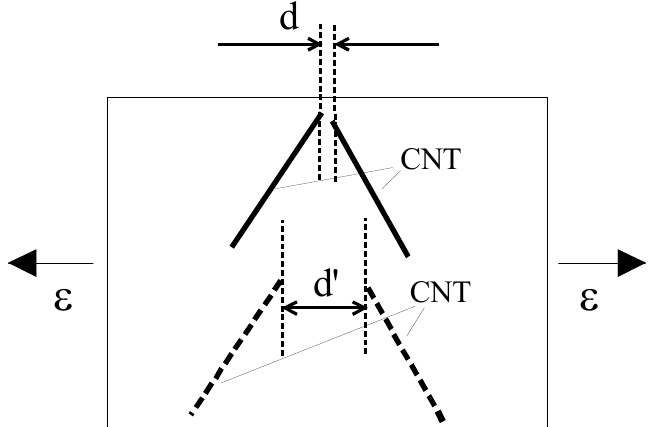
Figure 16. Schematic view of the working mechanism of MWNT-7/epoxy